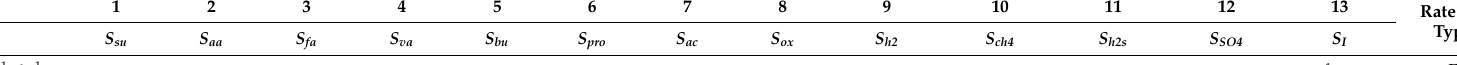
Table 2. Gujer matrix for the anaerobic fermentation model of salt-accumulating plants including sulfate reduction for soluble components (i = 1–13; j =